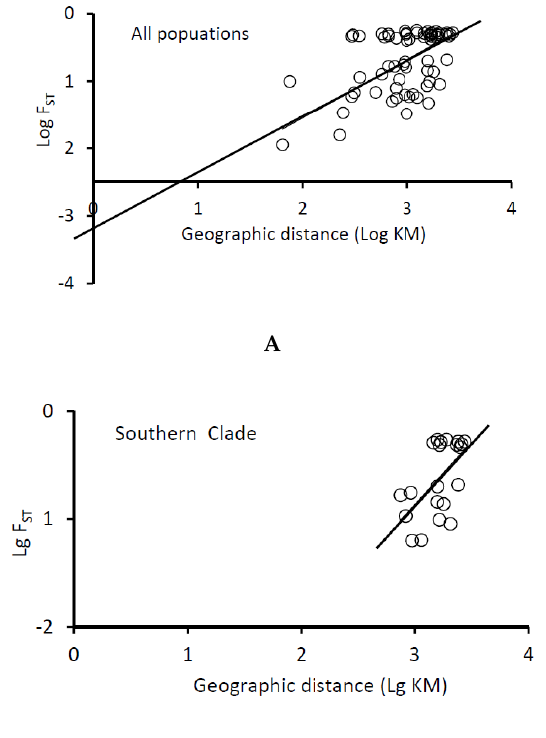
Figure 6. The relationship between the sampling latitude and the annual surface temperature of 12 populations. Triangles represent southern clade populations, circles represent northern clade populations.